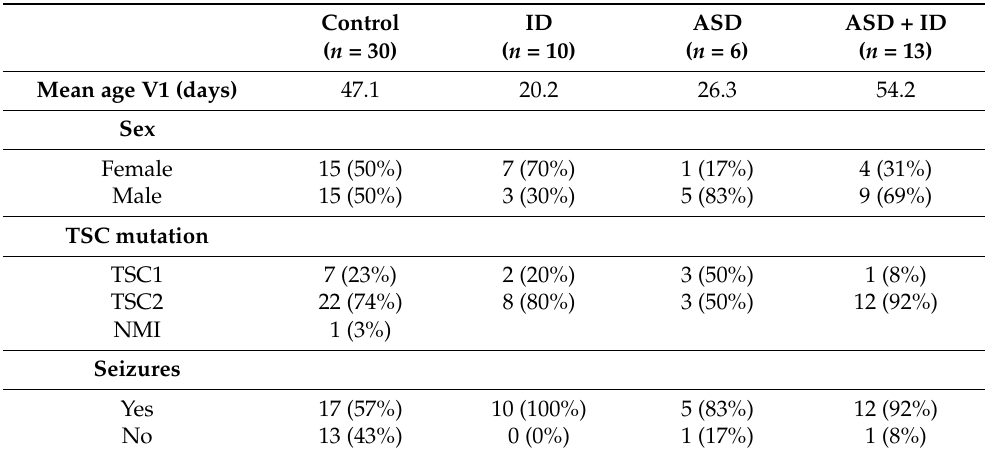
Table 1. Baseline of the study cohort and neurodevelopmental outcome at 24